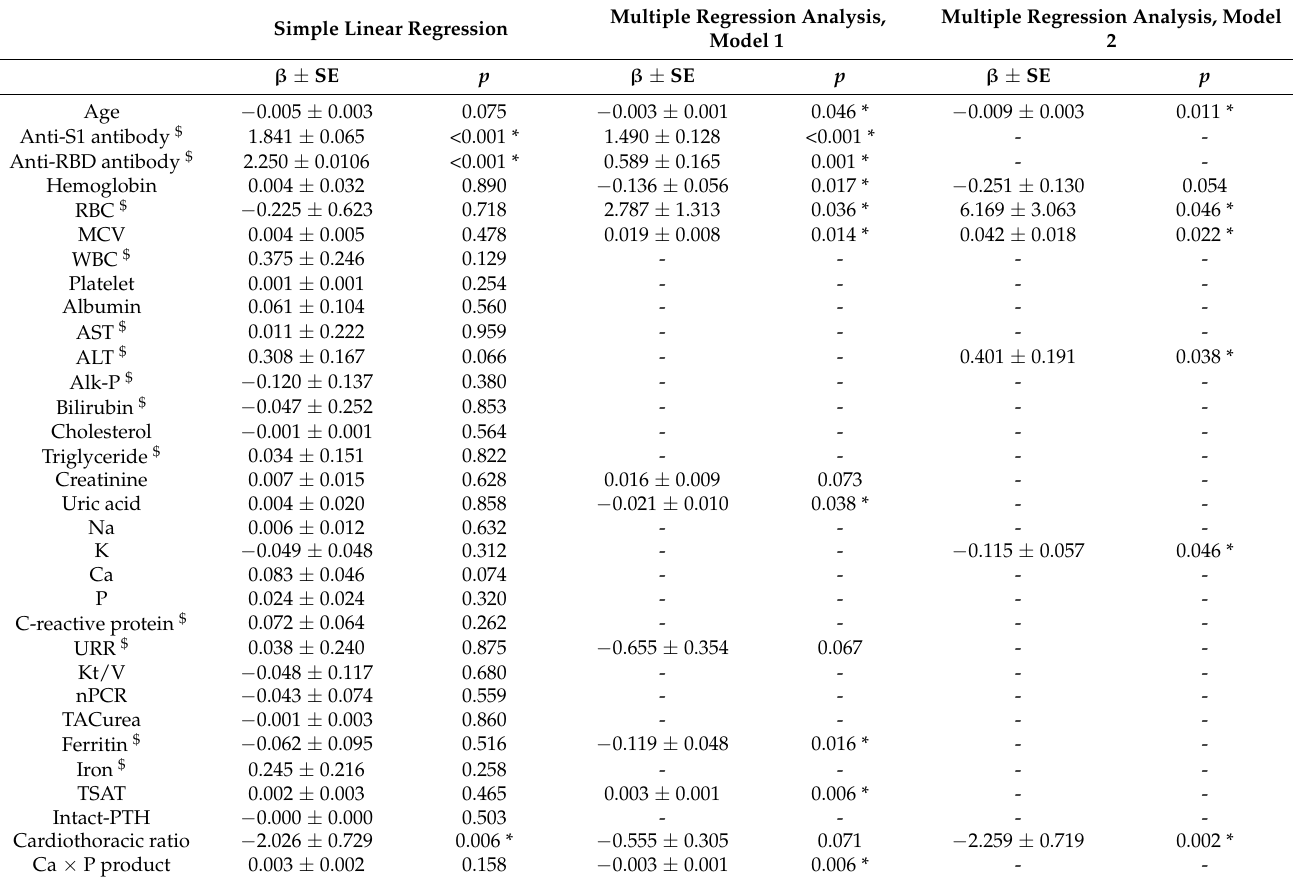
Table 2. β -coefficients between predicted NT 50 and independent